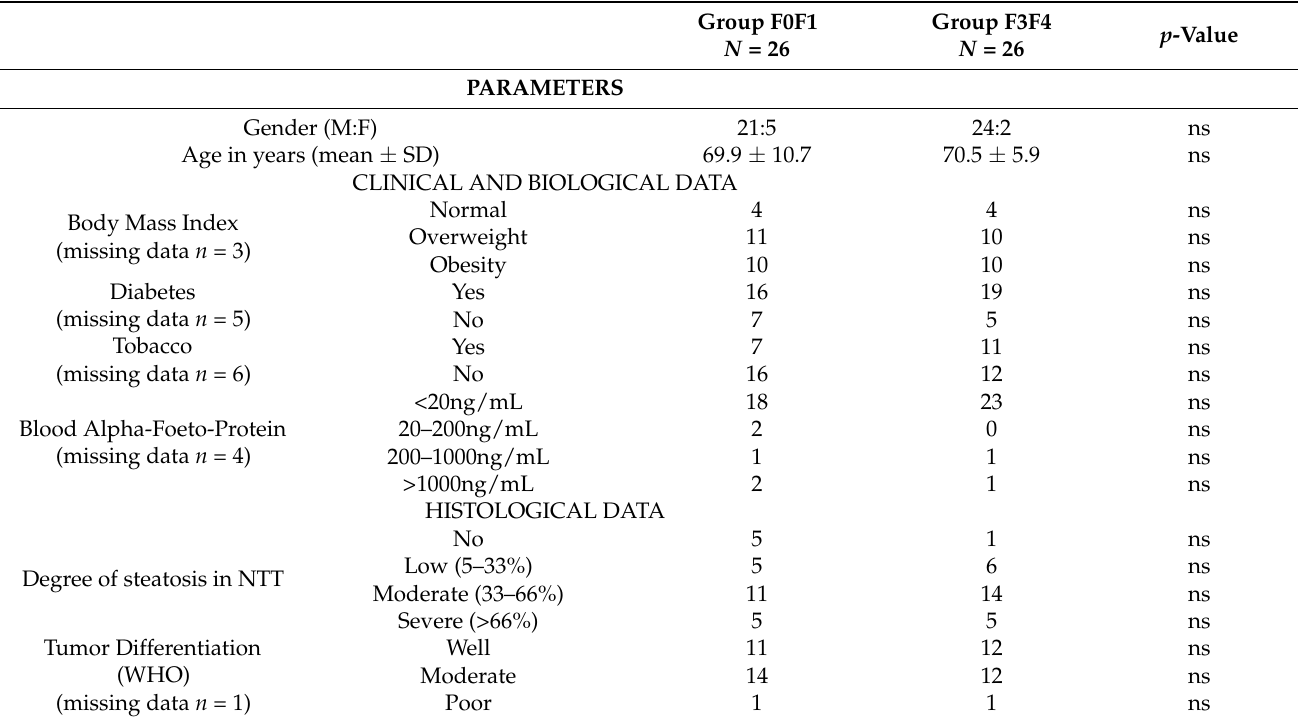
Table 1. Patients’